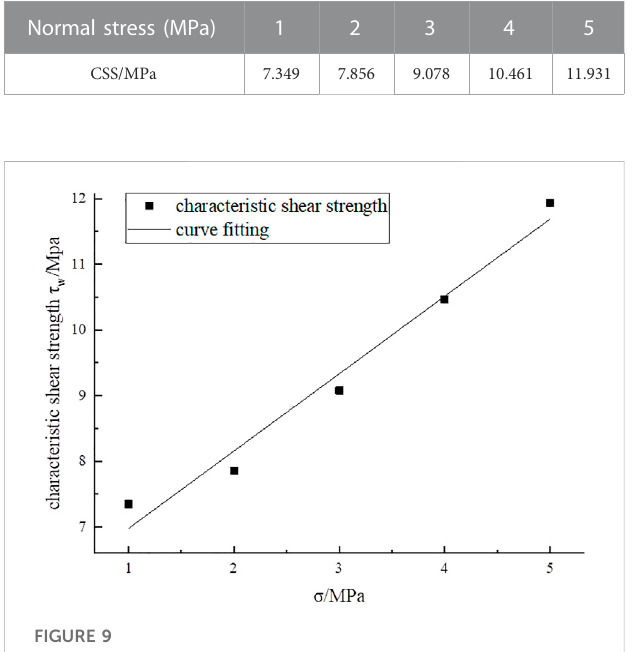
FIGURE 9 Fitting curve between CSS and normal stress.